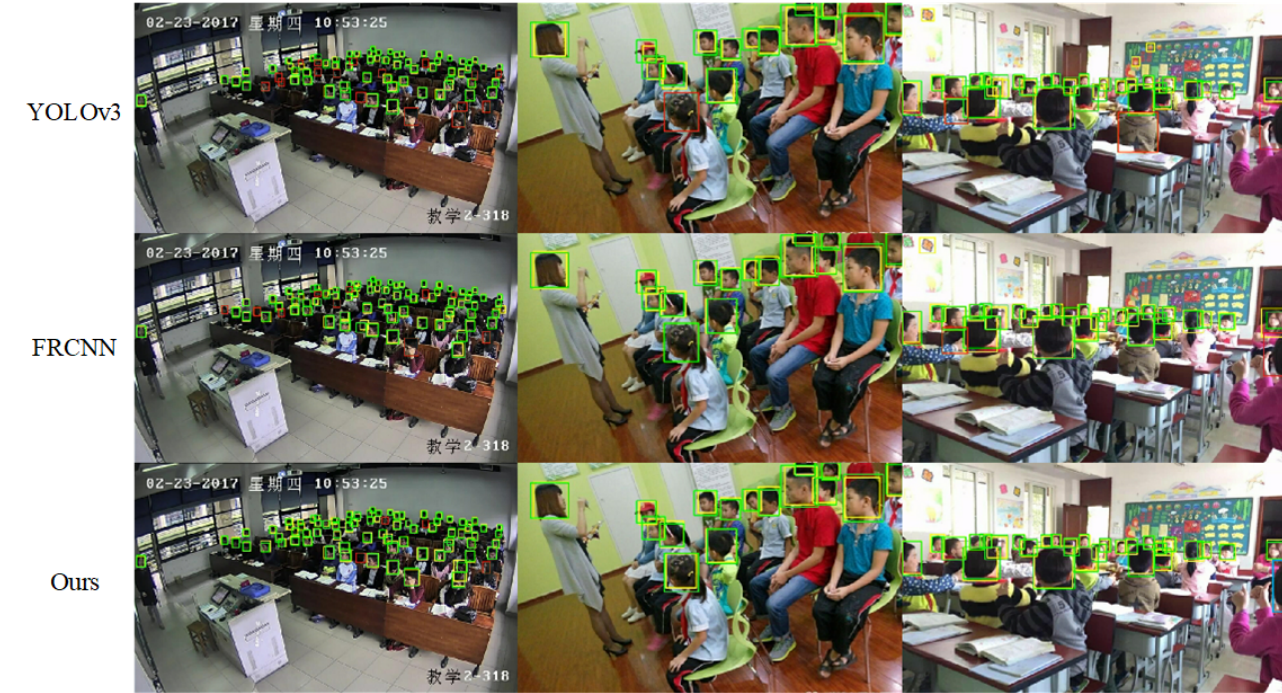
Figure 13. Qualitative results with different methods on the SCUT-HEAD